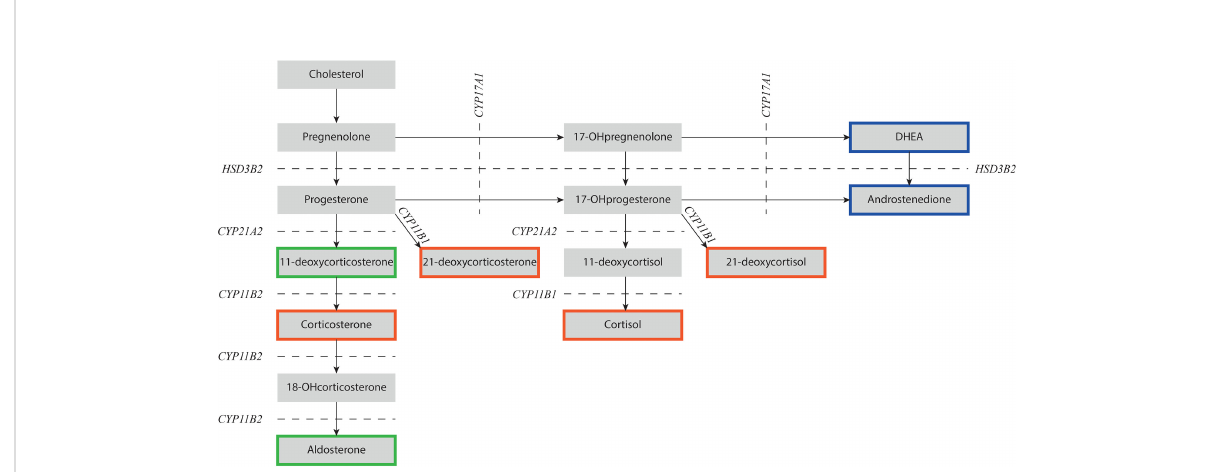
FIGURE 1 Schematic overview of adrenal steroidogenesis. NCCAH patients with 21OHD have impaired 21 a -hydroxylase activity ( CYP21A2 ) and NCCAH patients with 11OHD have impaired 11 b -hydroxylase activity ( CYP11B1 ). Precursor steroids prior to the enzymatic block increase and are shunted into androstenedione that can be converted into testosterone and dihydrotestosterone in the gonads. Steroids depicted in a red box have mainly glucocorticoid activity, steroids in a green box have mainly mineralocorticoid activity, and steroids in a blue box have mainly androgen activity. DHEA, dehydroepiandrosterone; CYP11B1 , 11 b -hydroxylase; CYP11B2 , aldosterone synthase; CYP17A1 , 17 a -hydroxylase/17,20-lyase; CYP21A2 , 21 a -hydroxylase; HSD3B2 , 3 b -hydroxysteroid dehydrogenase type 2; OH-,